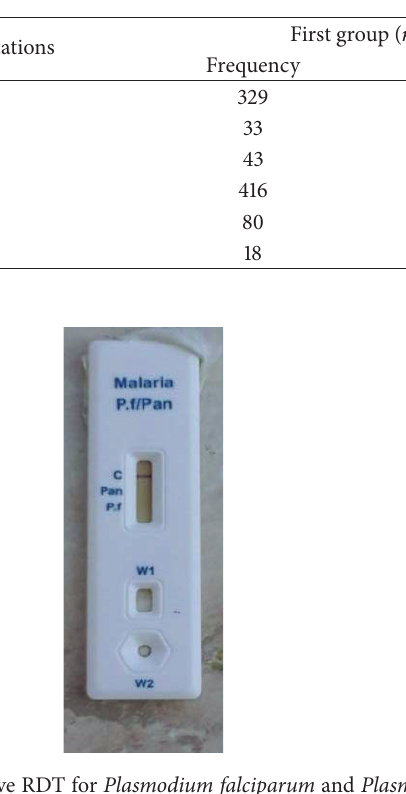
Table 1: Clinical manifestations detected in the study groups.